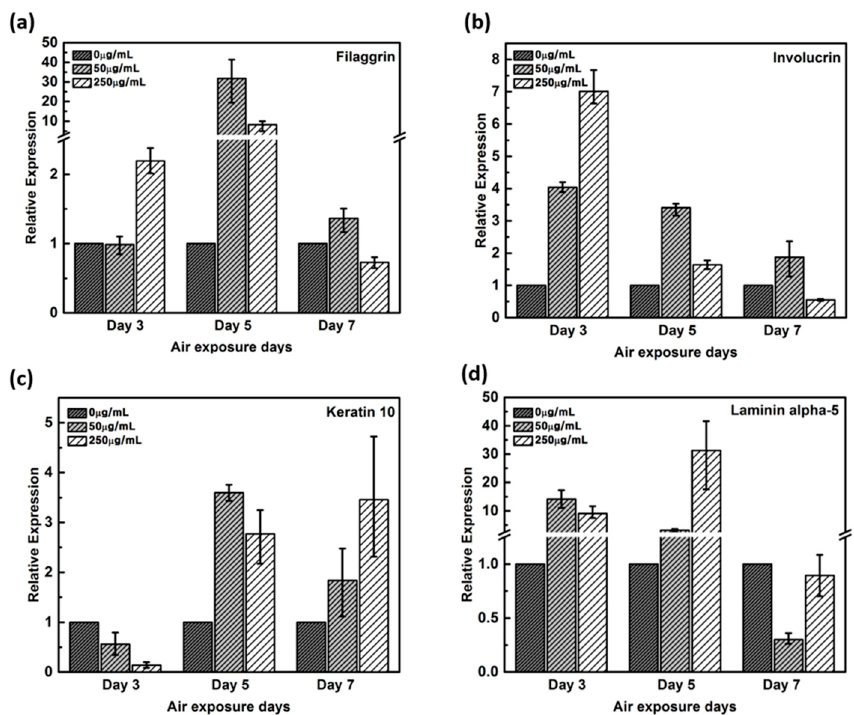
Figure 3. Relative gene expression of ( a ) filaggrin, ( b ) involucrin, ( c ) keratin 10, ( d ) laminin alpha-5 with varying CLLE-treated concentrations and period by real time qPCR. It quantified relative to negative control in each air exposure period on the basis of negative control.